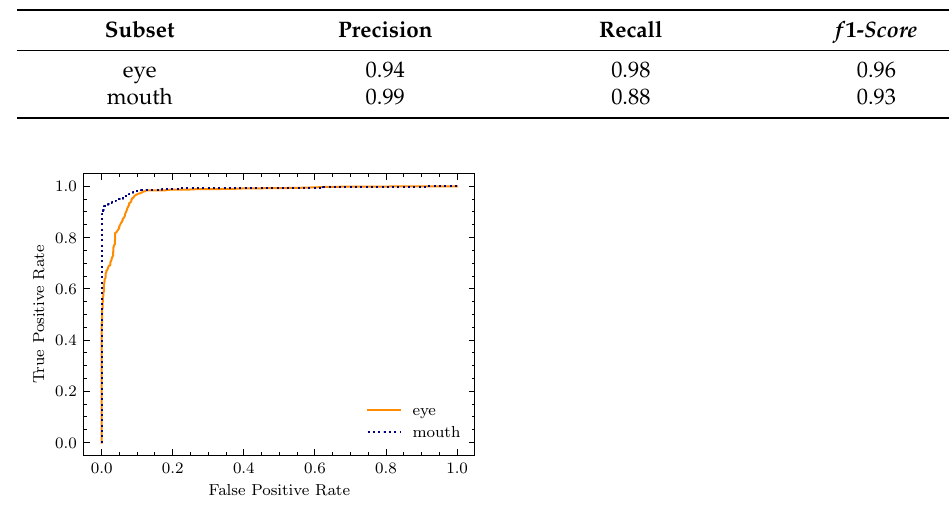
Table 3. Subset performance analysis.